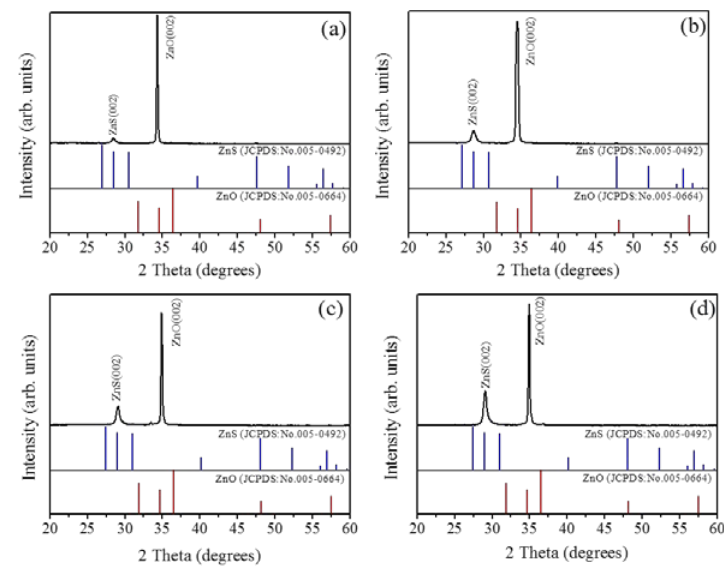
Figure 2. X-ray diffraction (XRD) patterns of ZnO-ZnS core-shell nanorods with various ZnS sputtering durations: ( a ) 10 min; ( b ) 20 min; ( c ) 40 min and ( d ) 60 min.